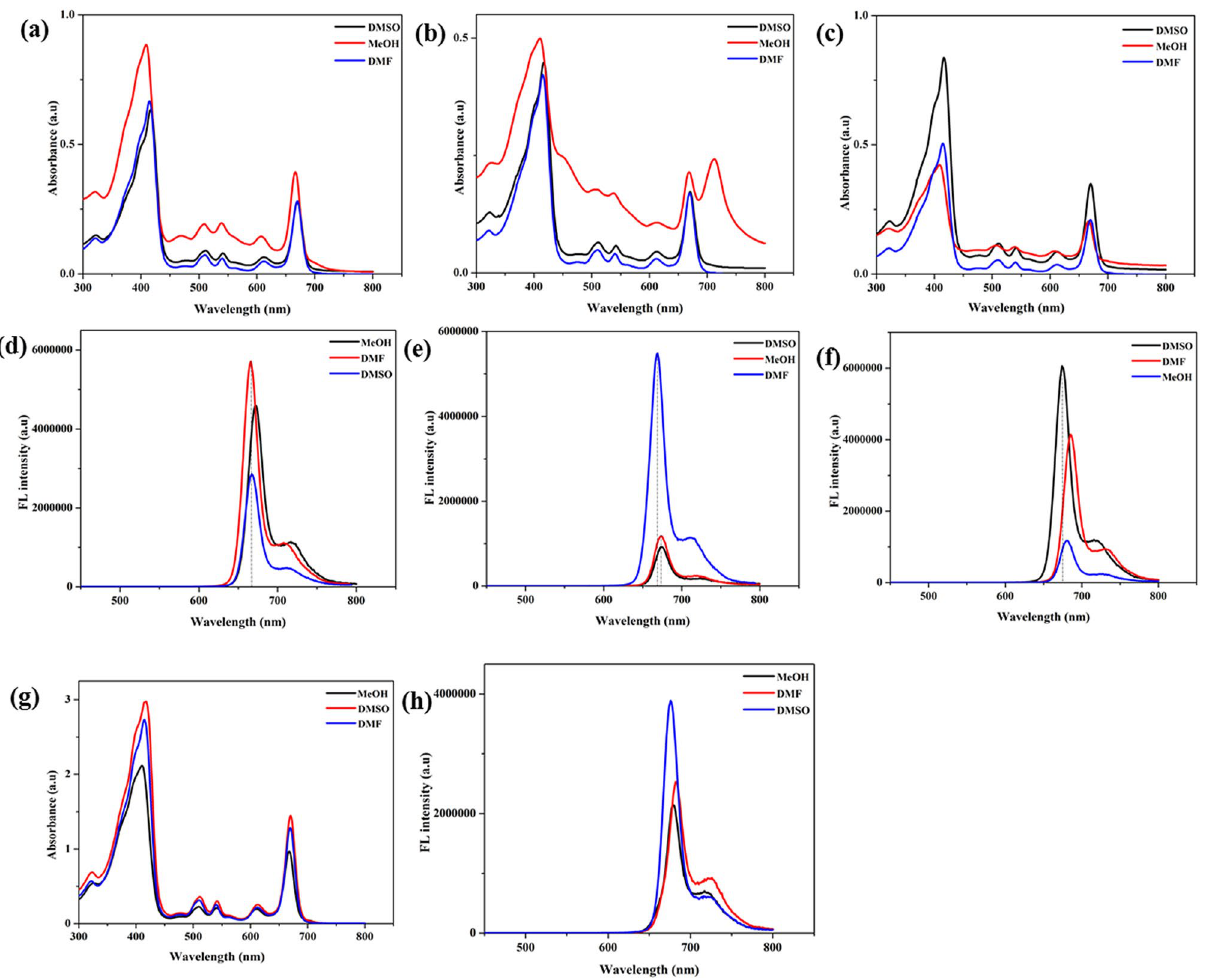
Figure 3. Absorbance of R-CPD conjugates ( a ) PPa-PD1, ( b ) PPa-PD2, ( c ) PPa-PD3, ( d ) Flourescence spectra of PPa-PD1, ( e ) PPa-PD2, ( f ) PPa-PD3, ( g ) PPa absorption spectra, ( h ) PPa fluorescence